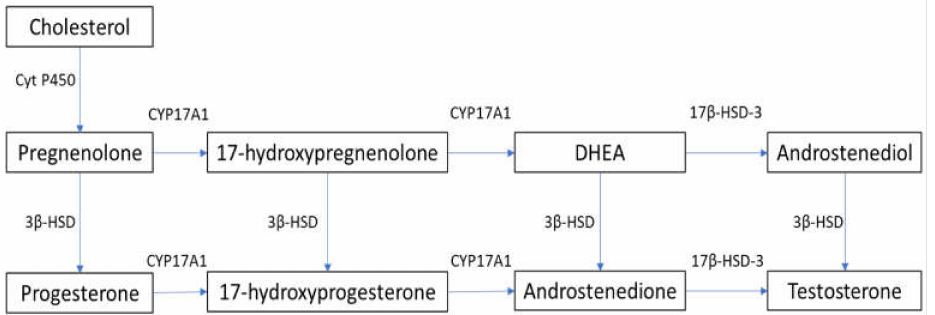
Figure 1. Steroidogenesis pathway. 3 β -HSD: 3 β -hydroxysteroid dehydrogenase; 17 β -HSD-3: 17 β - hydroxysteroid dehydrogenase-3; Cyt P450: cytochrome P450; CYP17A1: 17 α -hydroxylase; DHEA: